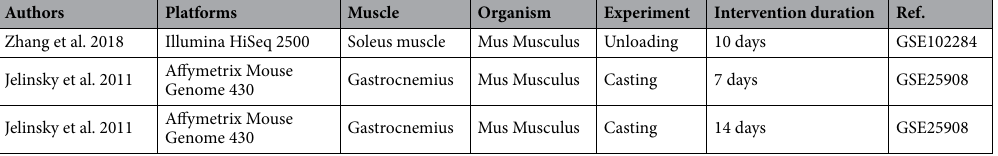
Table 6. Description of publicly available datasets of disuse muscle atrophy. Ref reference.